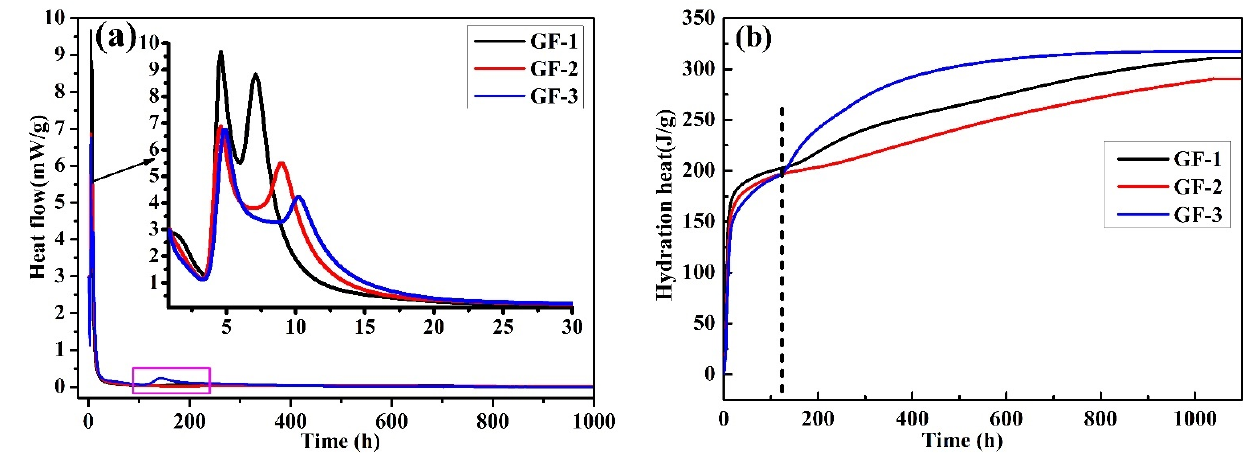
Figure 3. ( a ) The hydration heat flow and ( b ) total hydration heat of the